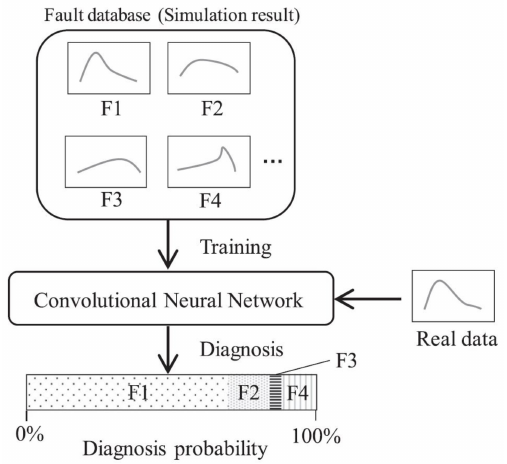
Figure 5. Fault diagnostic system using CNNs